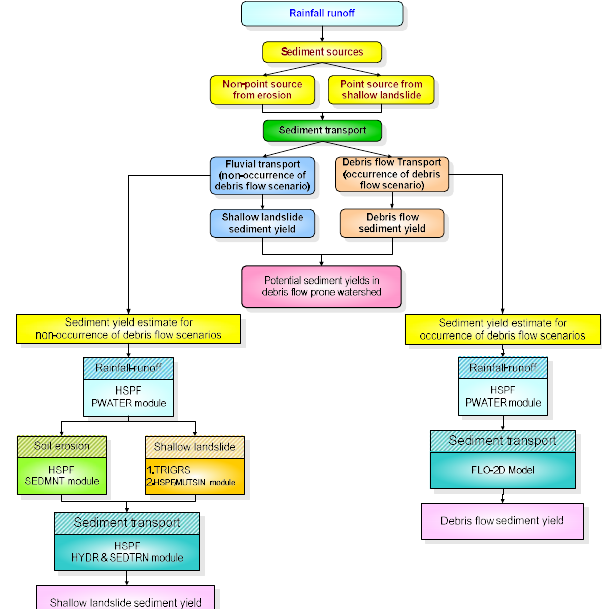
Fig. 3. A holistic framework for sediment yield estimate in hilly 601